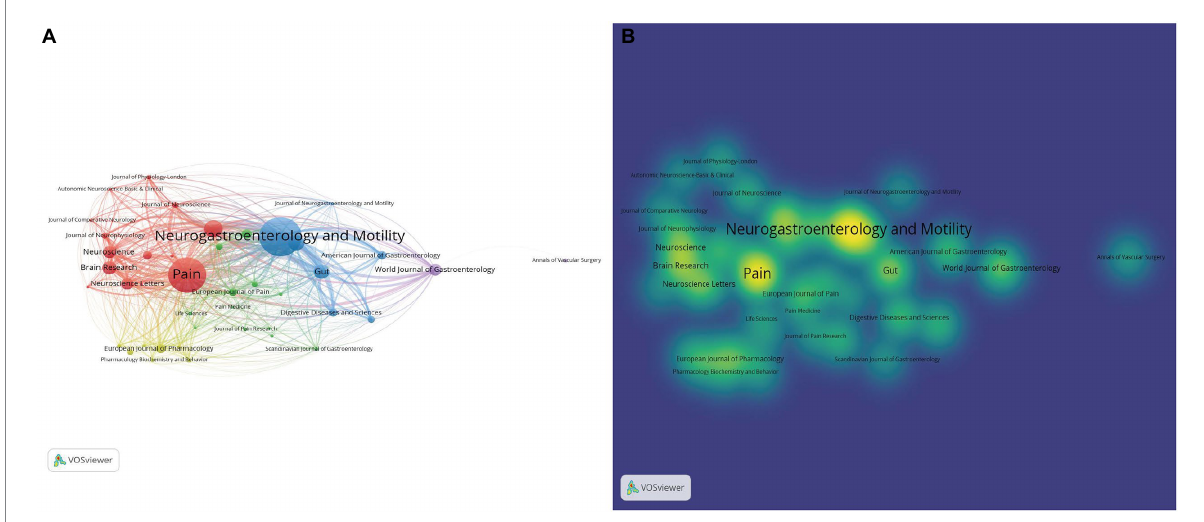
FIGURE 5 (A) The network map of journals in visceral pain research ( T ≥ 20). The size of node reflects the journal’s published papers, the link indicates the collaborated relationship between journals, and the same color of node represent the same cluster. (B) The density map of journals in visceral pain research ( T ≥ 20). The size of word, the size of round, and the opacity of yellow is positively related to the published papers.